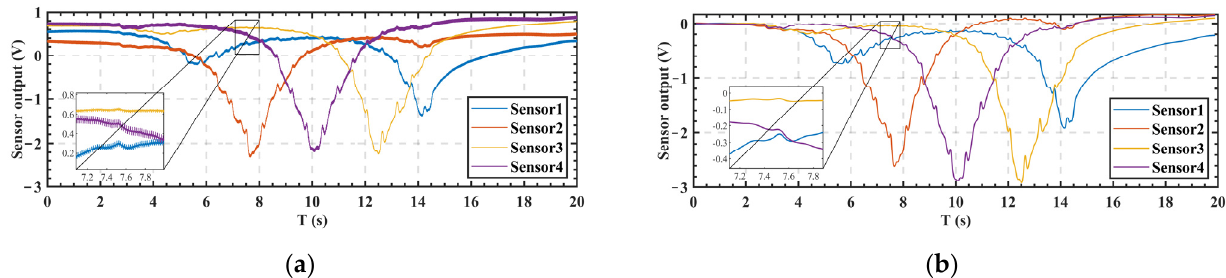
Figure 8. The output signals of the four electrostatic potential sensors. ( a ) Original data. ( b ) After data cleaning. data